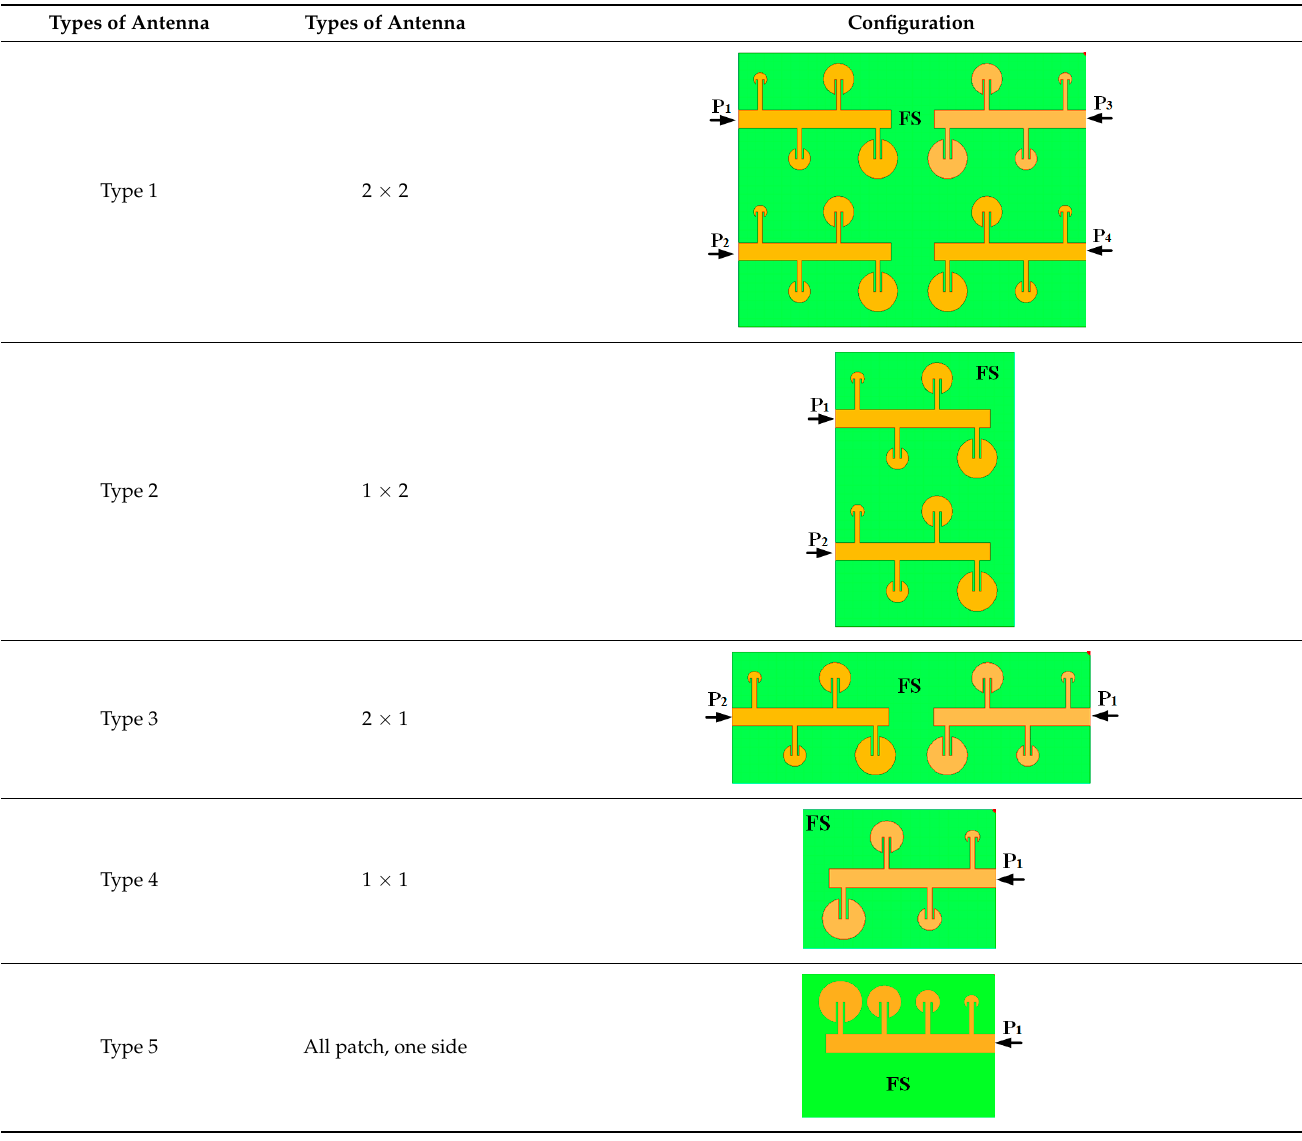
Figure A1. ( a ) Calculated S parameters for the type-2 antenna. Calculated directivity in ( b ) 2D (with co- and cross-polarization) and ( c ) 3D, by considering single-port (Port 1) excitation.